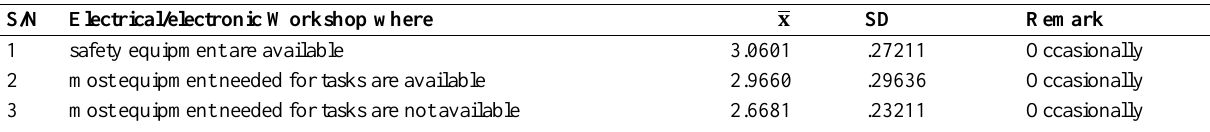
Table 4: Mean Score of Accident Rates in Different Electrical/Electronic Workshops having Different Level of Equipment Availability. S/N Electrical/electronic Workshop where 𝐱 SD Remark 3.0601 .27211 2.9660 .29636